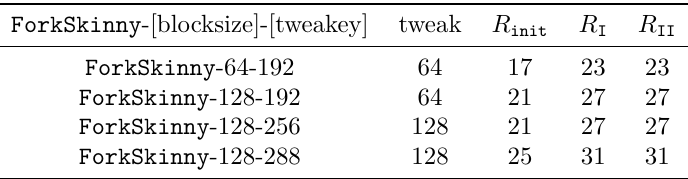
Table 12: Instances of ForkSkinny .